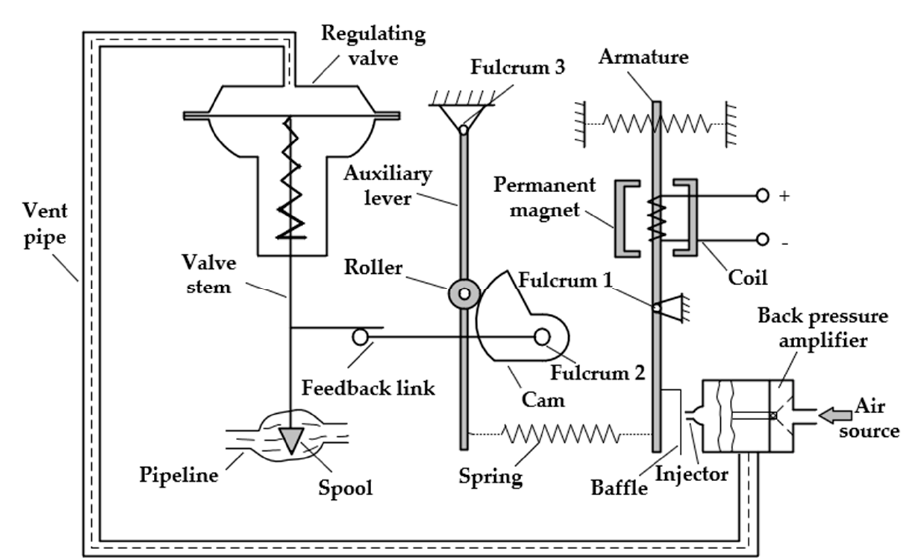
Figure 2. Internal structural diagram of the valve positioner.